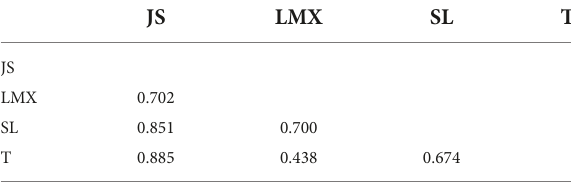
TABLE 5 Discriminant validity: heterotrait-monotrait ratio.